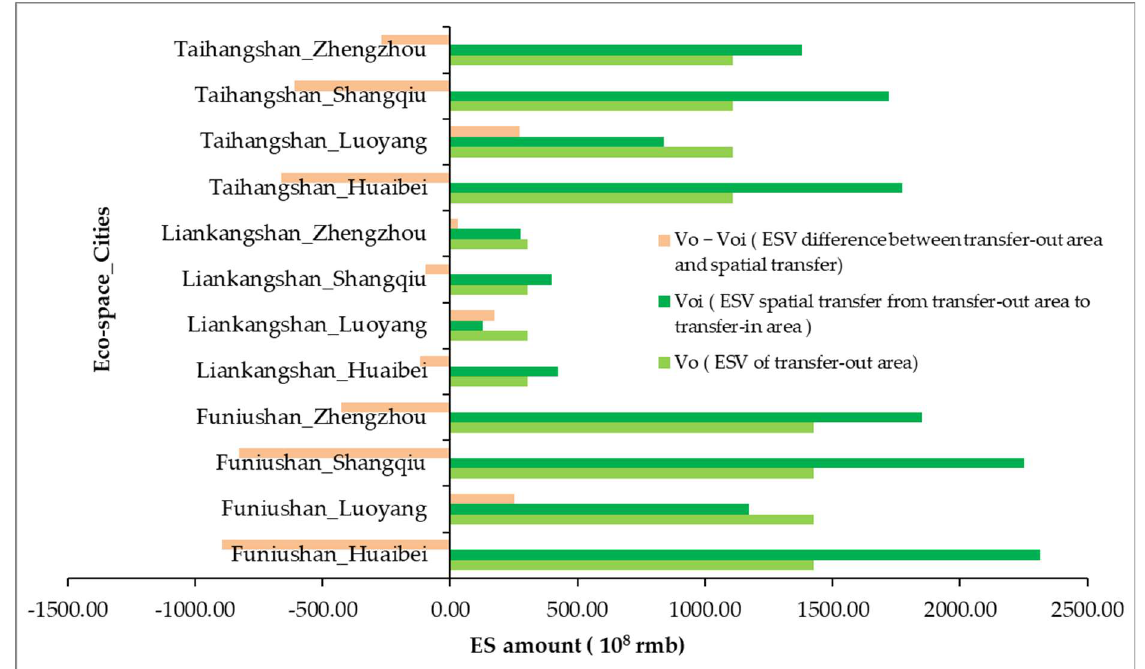
Figure 2. Comparison of V o and V oi in ES spatial transfer correlation.